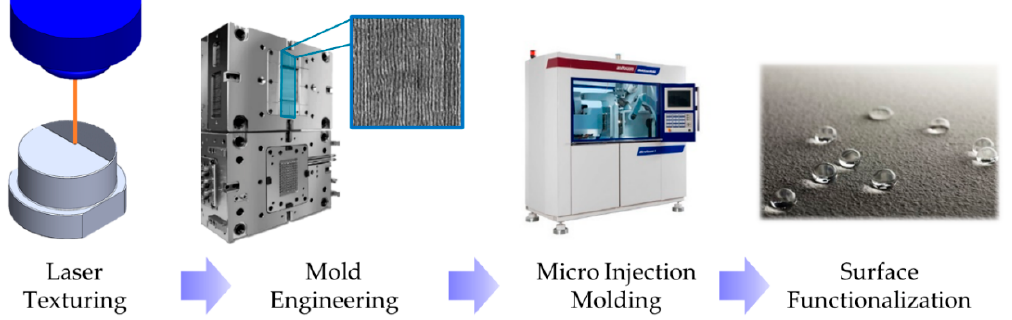
Figure 1. Schematic of the process chain utilized in this work to functionalize plastic parts.